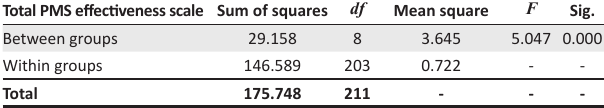
TABLE 8: One-way analysis of variance to compare the mean scores of the performance management system effectiveness between the post